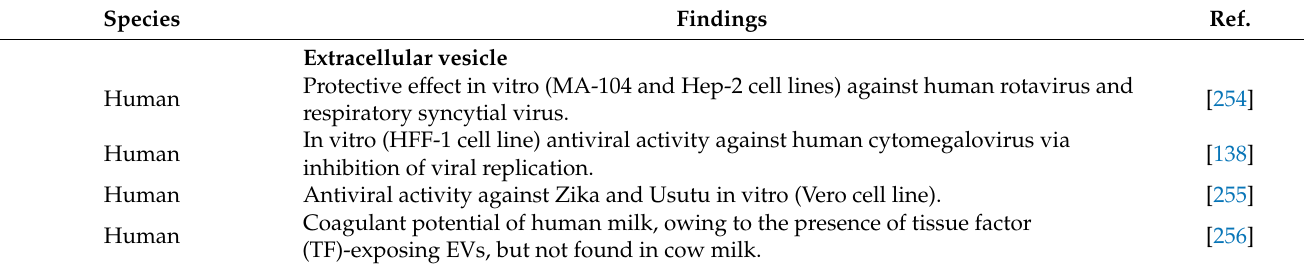
Table 7. Major findings of studies on the biological effects of mammalian milk-derived EVs. Species